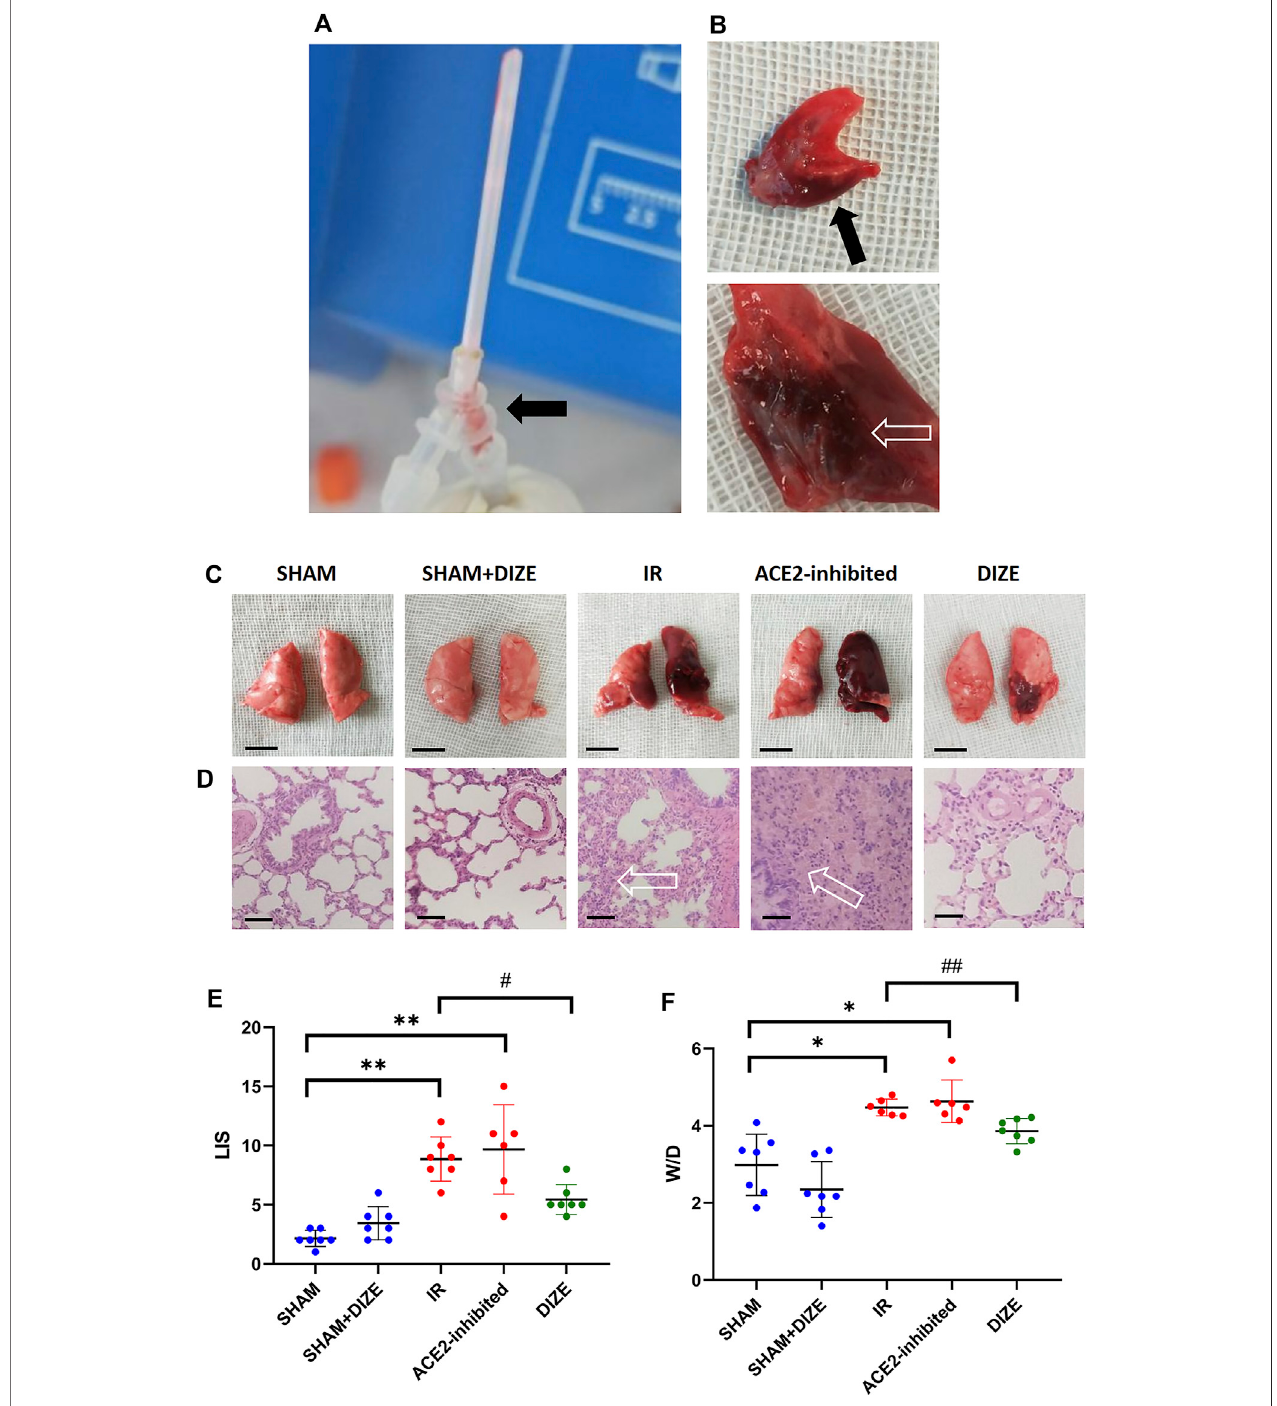
FIGURE4| Manifestationoflungischemia-reperfusion (IR)injury. (A) Theexperimentalillustration. Theexperiment animalproducedpinkfrothing phlegm(arrow) in the endotracheal tube. (B) The cut surface of the lung revealed acute pulmonary edema and congestion (arrow) in the IR rat model. (C) Gross view in different groups (scale bar 1 cm). (D) HE staining ( × 400 magni fi cation); arrow-massive in fl ammatory cells and pink liquid secretion in the alveolar space and alveolar septum, resulted in severedestructionofthealveolarstructure(scalebar50 µm). (E) Lunginjuryscore(LIS)indifferentgroups. (F) Wet/Dryratio.Datawereexpressedasmean ± SEM. * p < 0.05, ** p < 0.01 vs. SHAM group; # p < 0.05, ## p < 0.01 vs. IR group, n (cid:1) 7.